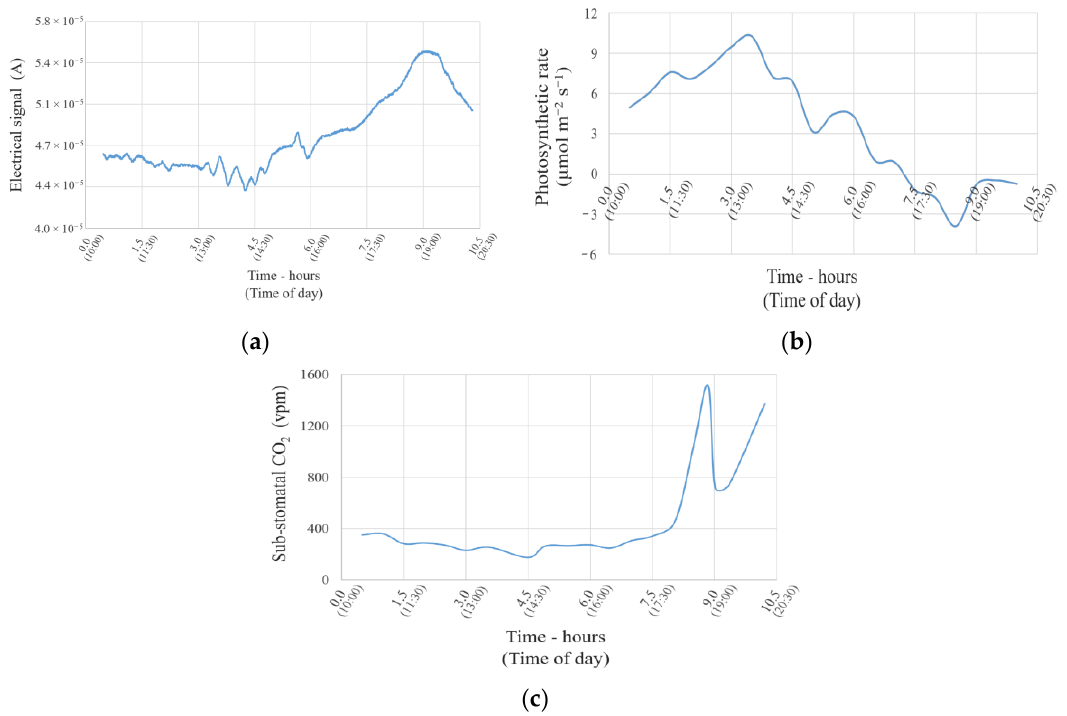
Figure 3. The electrical signal ( a ), the photosynthesis rate ( b ), and the amount of CO 2 ( c ) registered for V7 (MgSO 4 – KNO 3 – KH 2 PO 4 ).